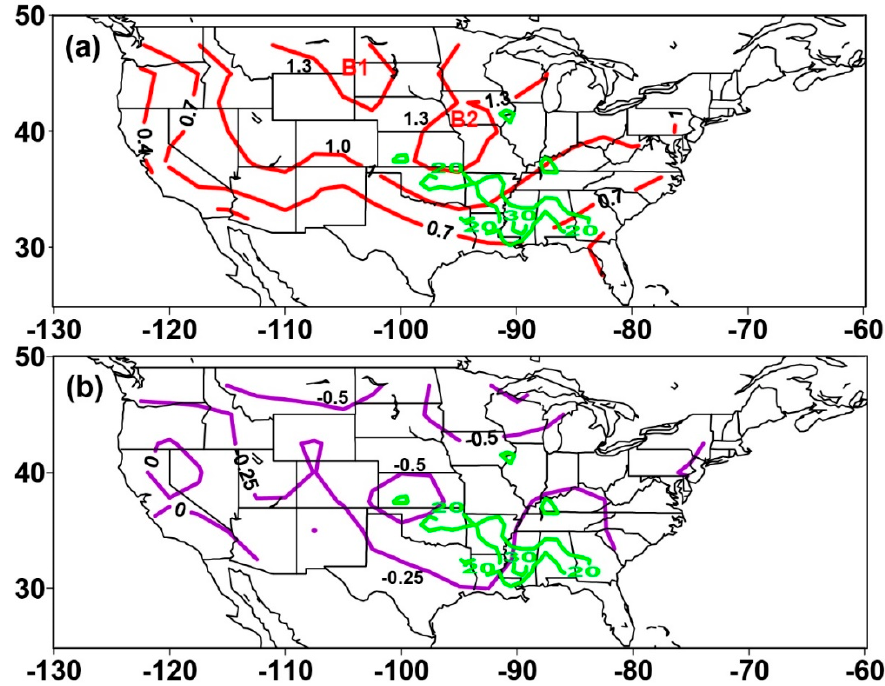
Figure 5. Composite for 10 warmest years of ( a ) surface air temperature anomaly (°C) with relative warm centers labelled by B1 and B2, and ( b ) mean sea level pressure anomaly (Pa). The (E)F1-(E)F5 tornado counts (contours) over the same period are in green colors in ( a ) and ( b ).